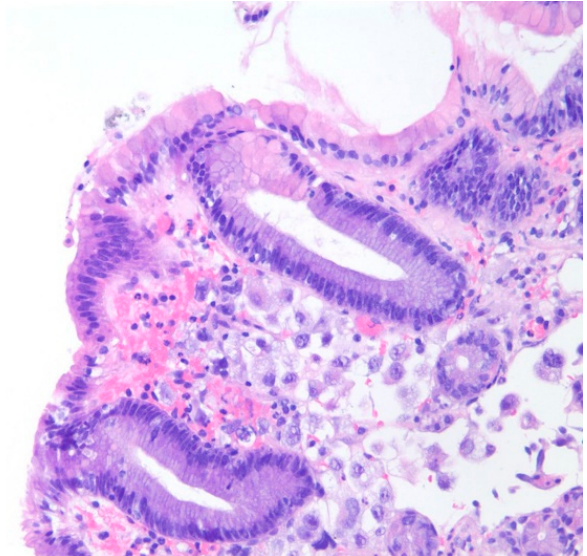
Figure 3. Poorly differentiated carcinoma cells are seen at the mucosal neck region of the gastric foveolar epithelium on hematoxylin and eosin stain at 200× magnification. A 73-year-old female was initially diagnosed with left-sided renal cell carcinoma and underwent nephrectomy, however few years later developed a right-sided renal mass along with pulmonary nodules. She underwent partial right nephrectomy with right up-